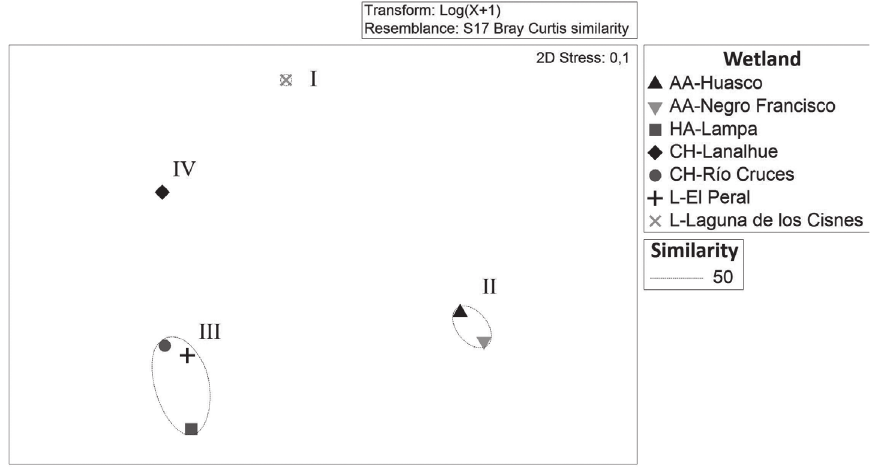
Figure 2. Multidimensional ordering (MDS) of the composition and abundance of bird species between seven wetlands (Stress: 0.12) based on the Bray-Curtis similarity index. Ellipses and numbers show groups with 50% similarity. AA= High-Andean wetlands (Huasco and Negro Francisco), HA= man-made wet- land (Tranque San Rafael), CH= wetland complexes (Lago Lanalhue and Río Cruces), L= Lagoon (El Peral, Los Table 5. Analysis of the percentage contribution of species to dissimilarity (SIMPER).